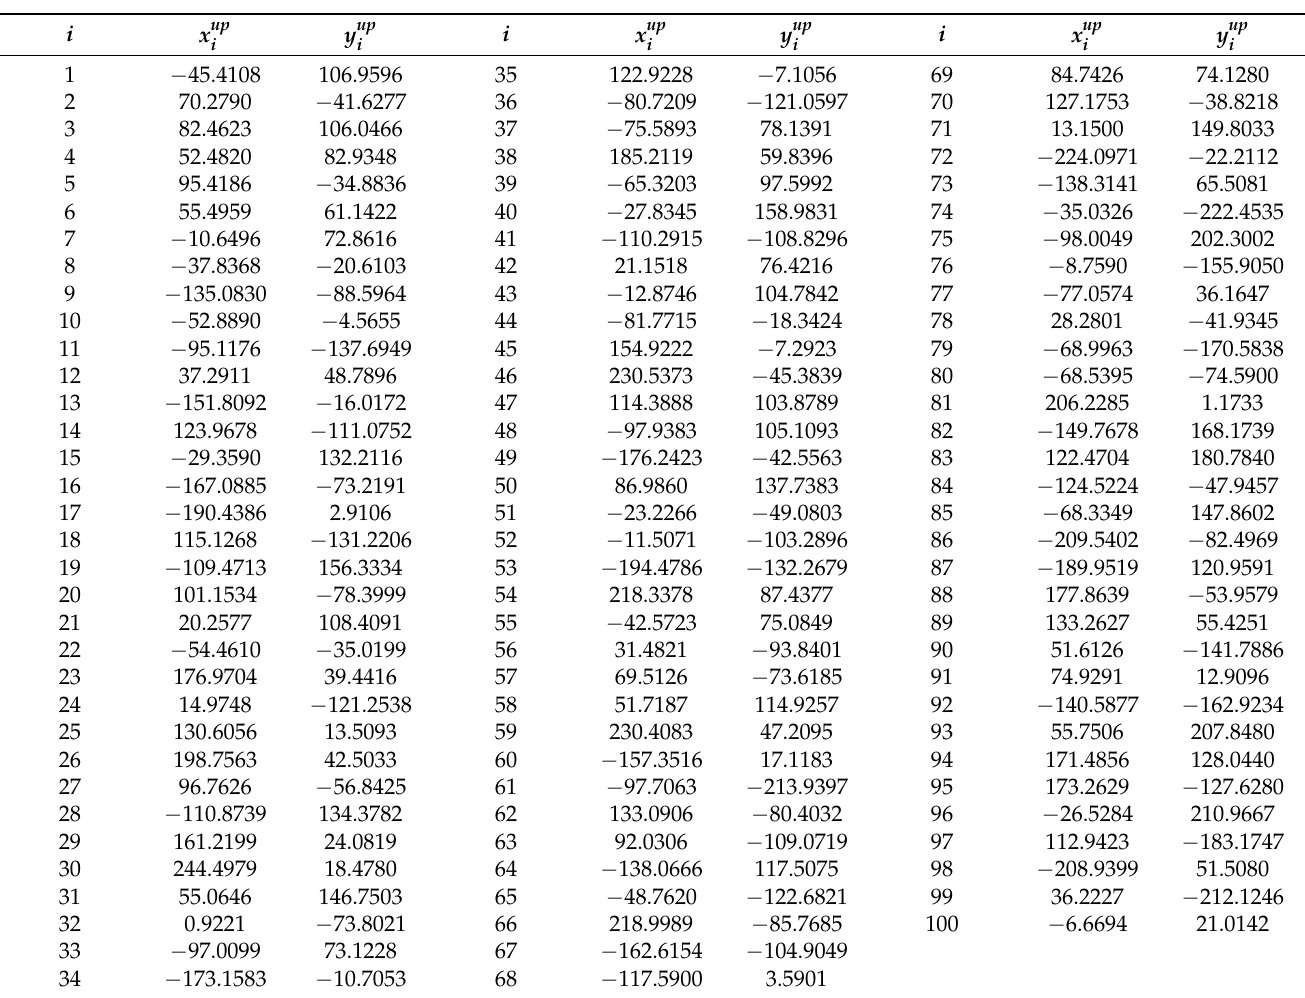
Table 3. Coordinates of the placement of 100 circles for the parallel solution, r up = 257.1951